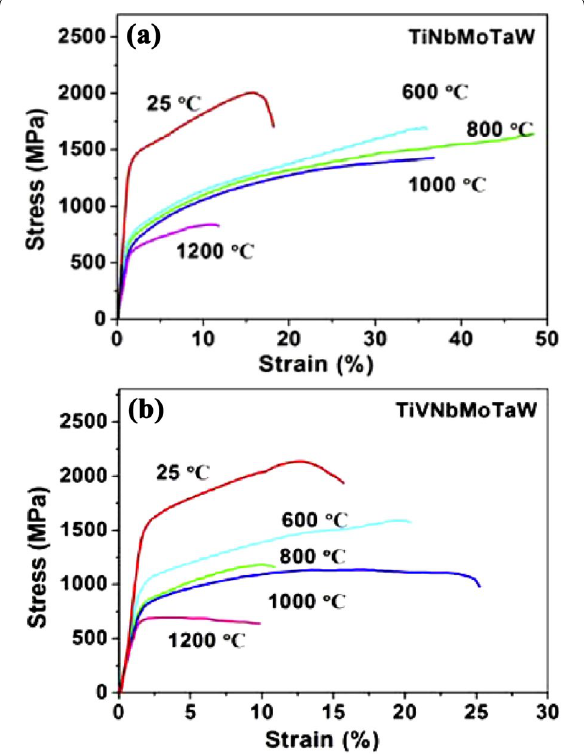
Figure 2 The compressive stress-strain curves of the TiNbMoTaW ( a ) and TiVNbTaMoW ( b ) HEAs at room temperature and elevated temperatures